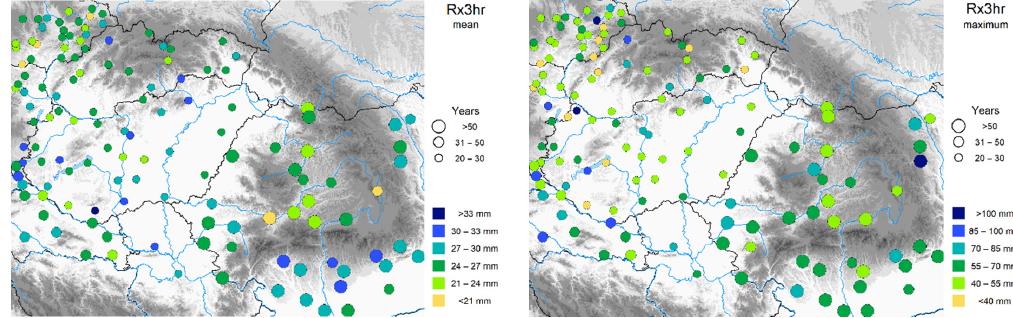
Figure 3. Annual average of 1-h maxima (Rx1hr) ( left ) and the maximum 1-h precipitation ( right ). The size of the markers represents the lengths of the available data series, whereas different colours present the range of values.